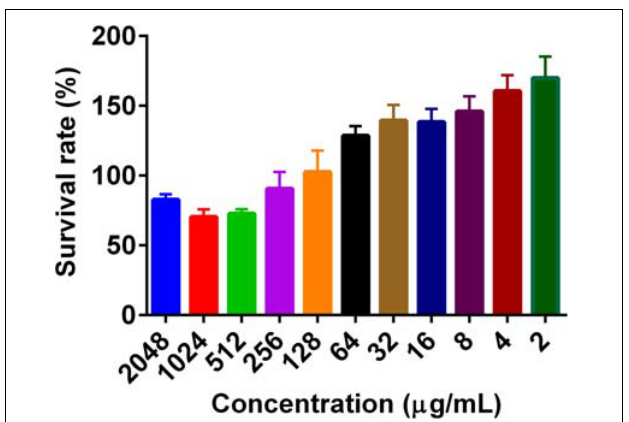
FIGURE 1 | The effect of pyrogallol on the cell viability. The cells were treated with different concentrations of PG and incubated overnight, and the cell viability was determined using MTT reagent. Data is presented as Mean ± SEM.